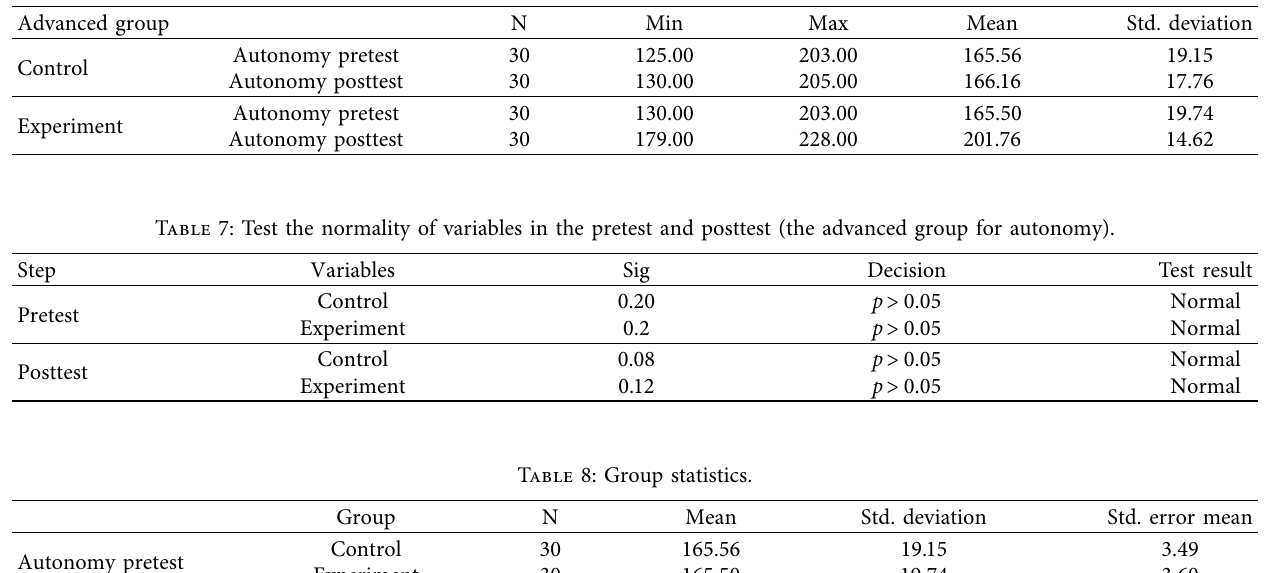
Table 6: Descriptive statistic for autonomy in advanced groups.